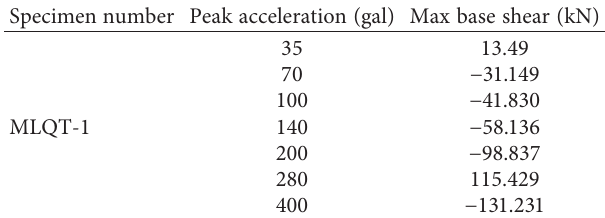
Table 5: Maximum shear with peak acceleration